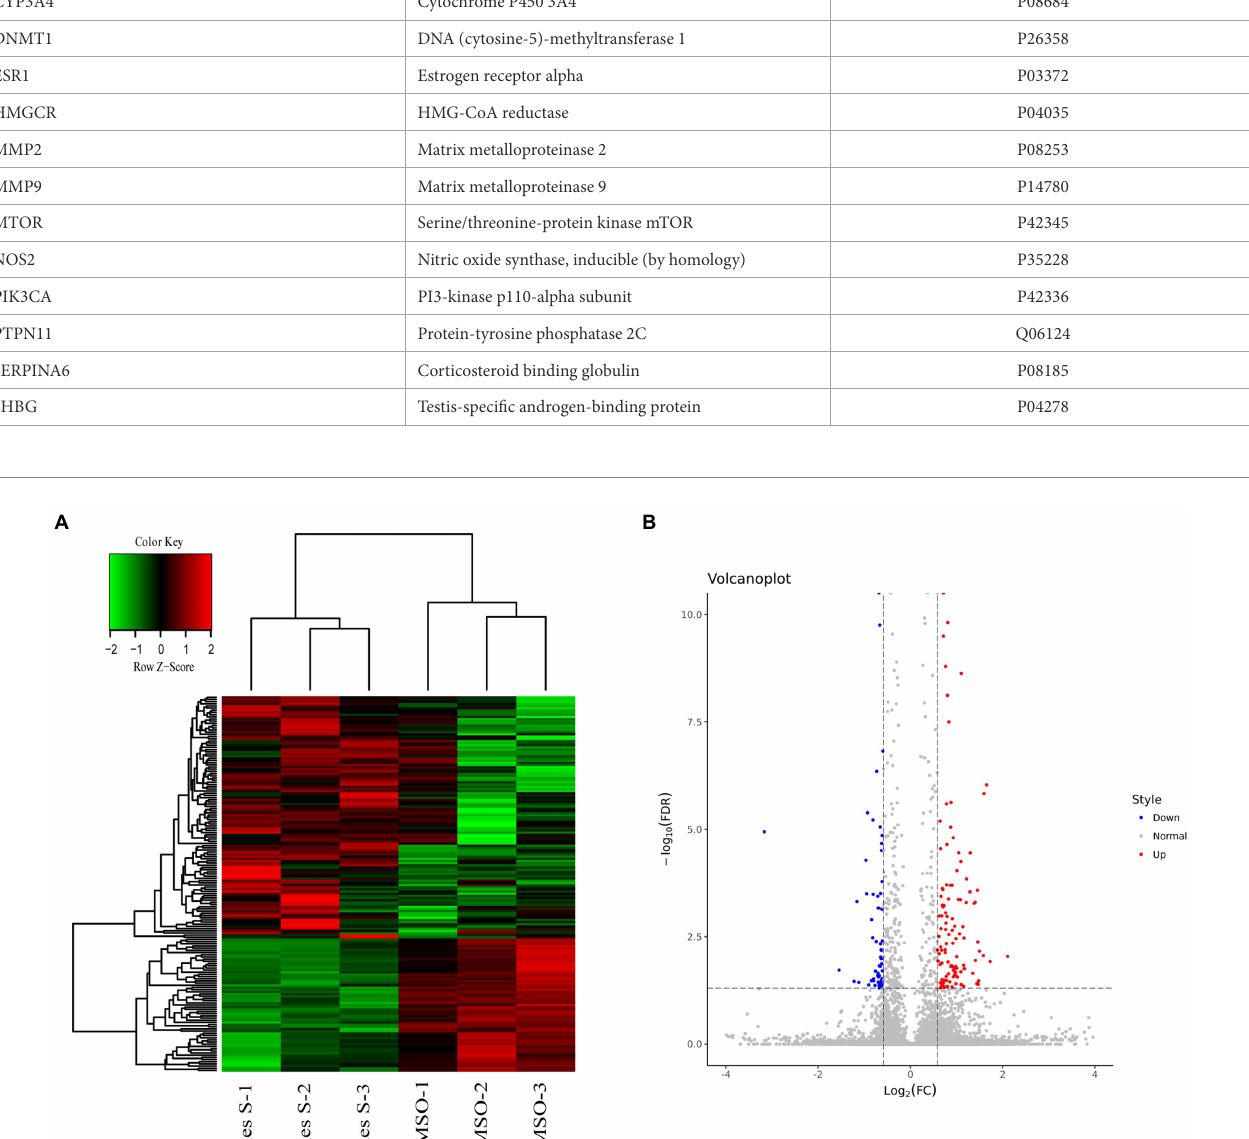
anti-apoptosis and peripheral metabolic effects. Studies have shown that the inhibition of ROS production mediated by AKT1 inhibits the fibrosis transformation from NAFLD to liver (19). AKT1 deficiency led to the